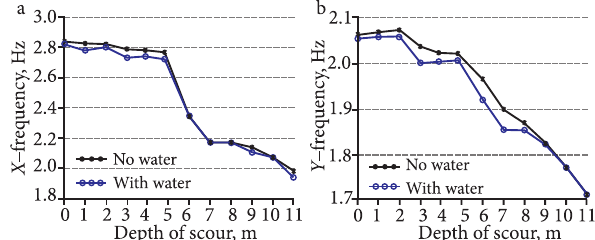
Fig. 2 . Bridge natural frequencies changing with the scour depth: a − X direction (longitudinal direction); b − Y direction (transverse direction)